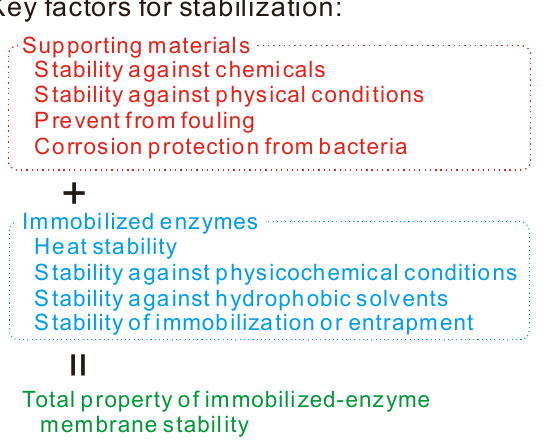
Figure 1. Scheme of key factors for stabilization of immobilized-enzyme membranes and relation to the two elements, supporting materials and immobilized enzymes.